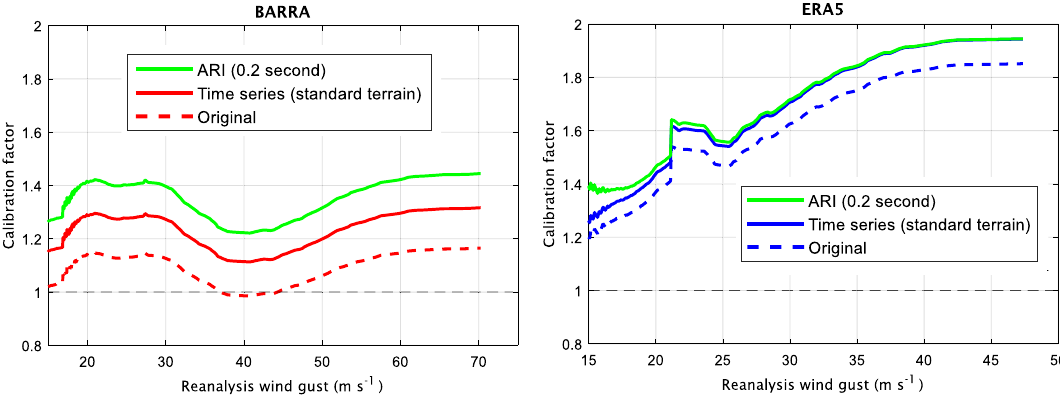
Figure 2. Smoothed calibration factors that are applied to reanalysis wind gusts to make them more consistent with observation wind gust values. A calibration factor of 1 indicates no calibration is